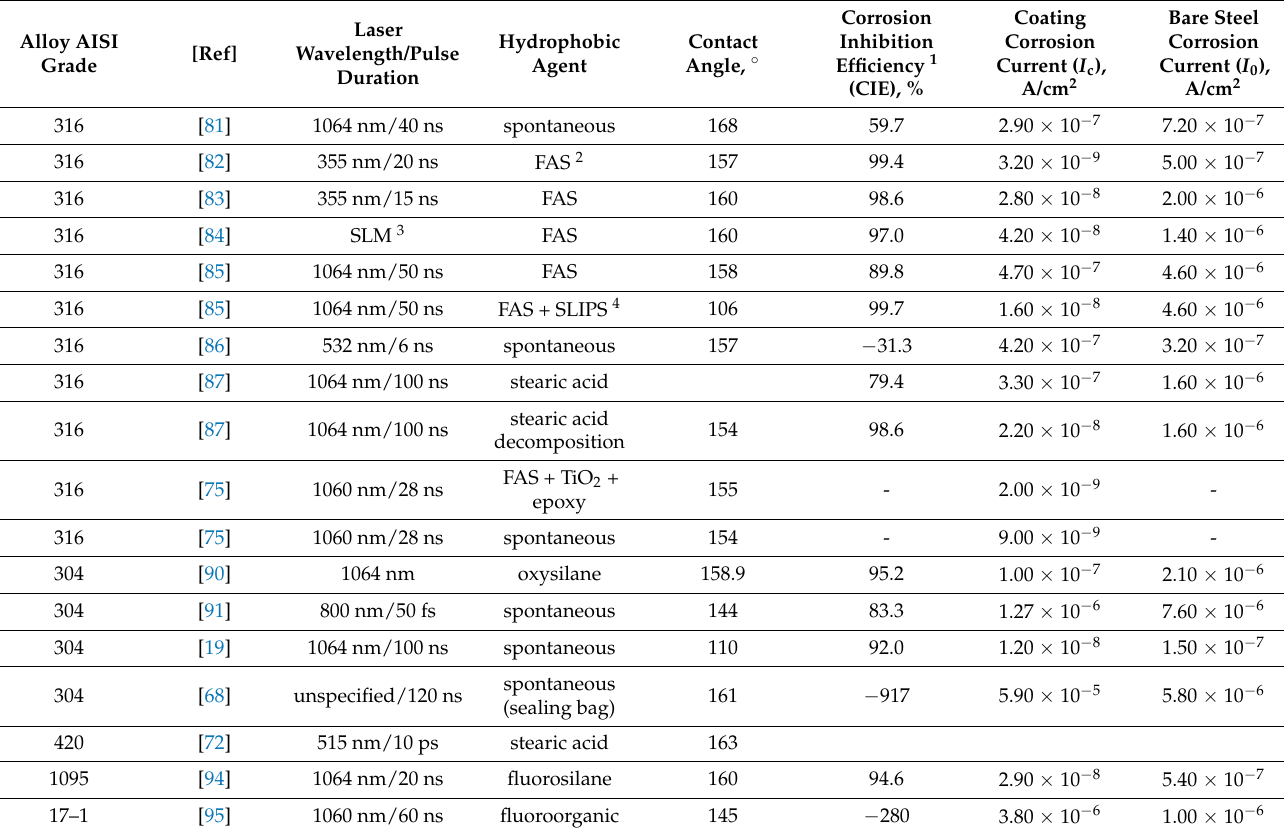
Table 1. Protective properties of superhydrophobic coatings on laser-treated stainless steel presented in the